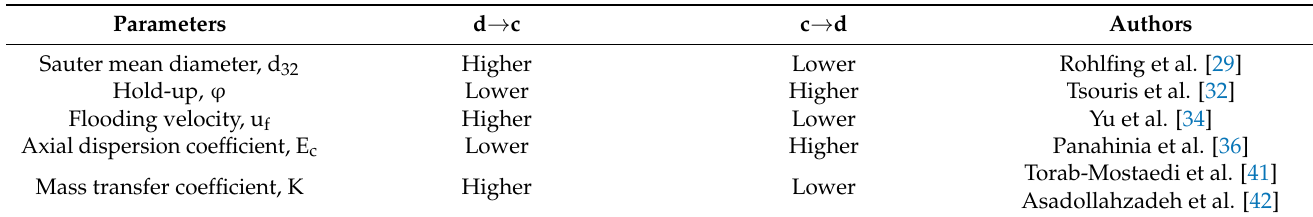
Table 1. The effect of mass transfer direction on performance